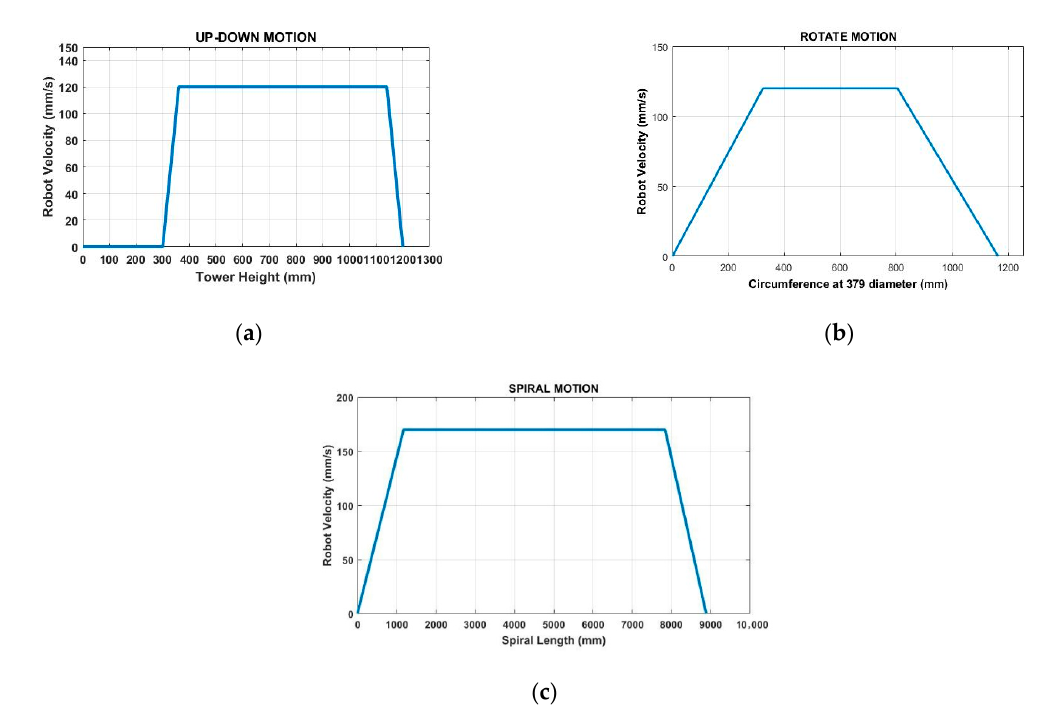
Figure 8. Robot Ideal Motion: ( a ) up-down; ( b ) rotation; ( c ) spiral.